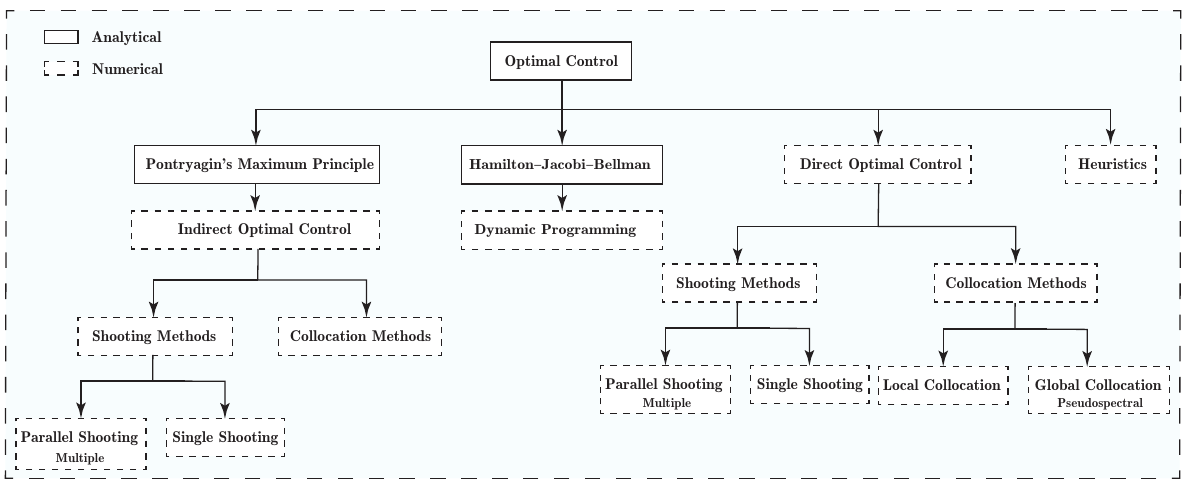
Figure 3. A classification of the optimal control methods used to solve aircraft trajectory optimiza- tion